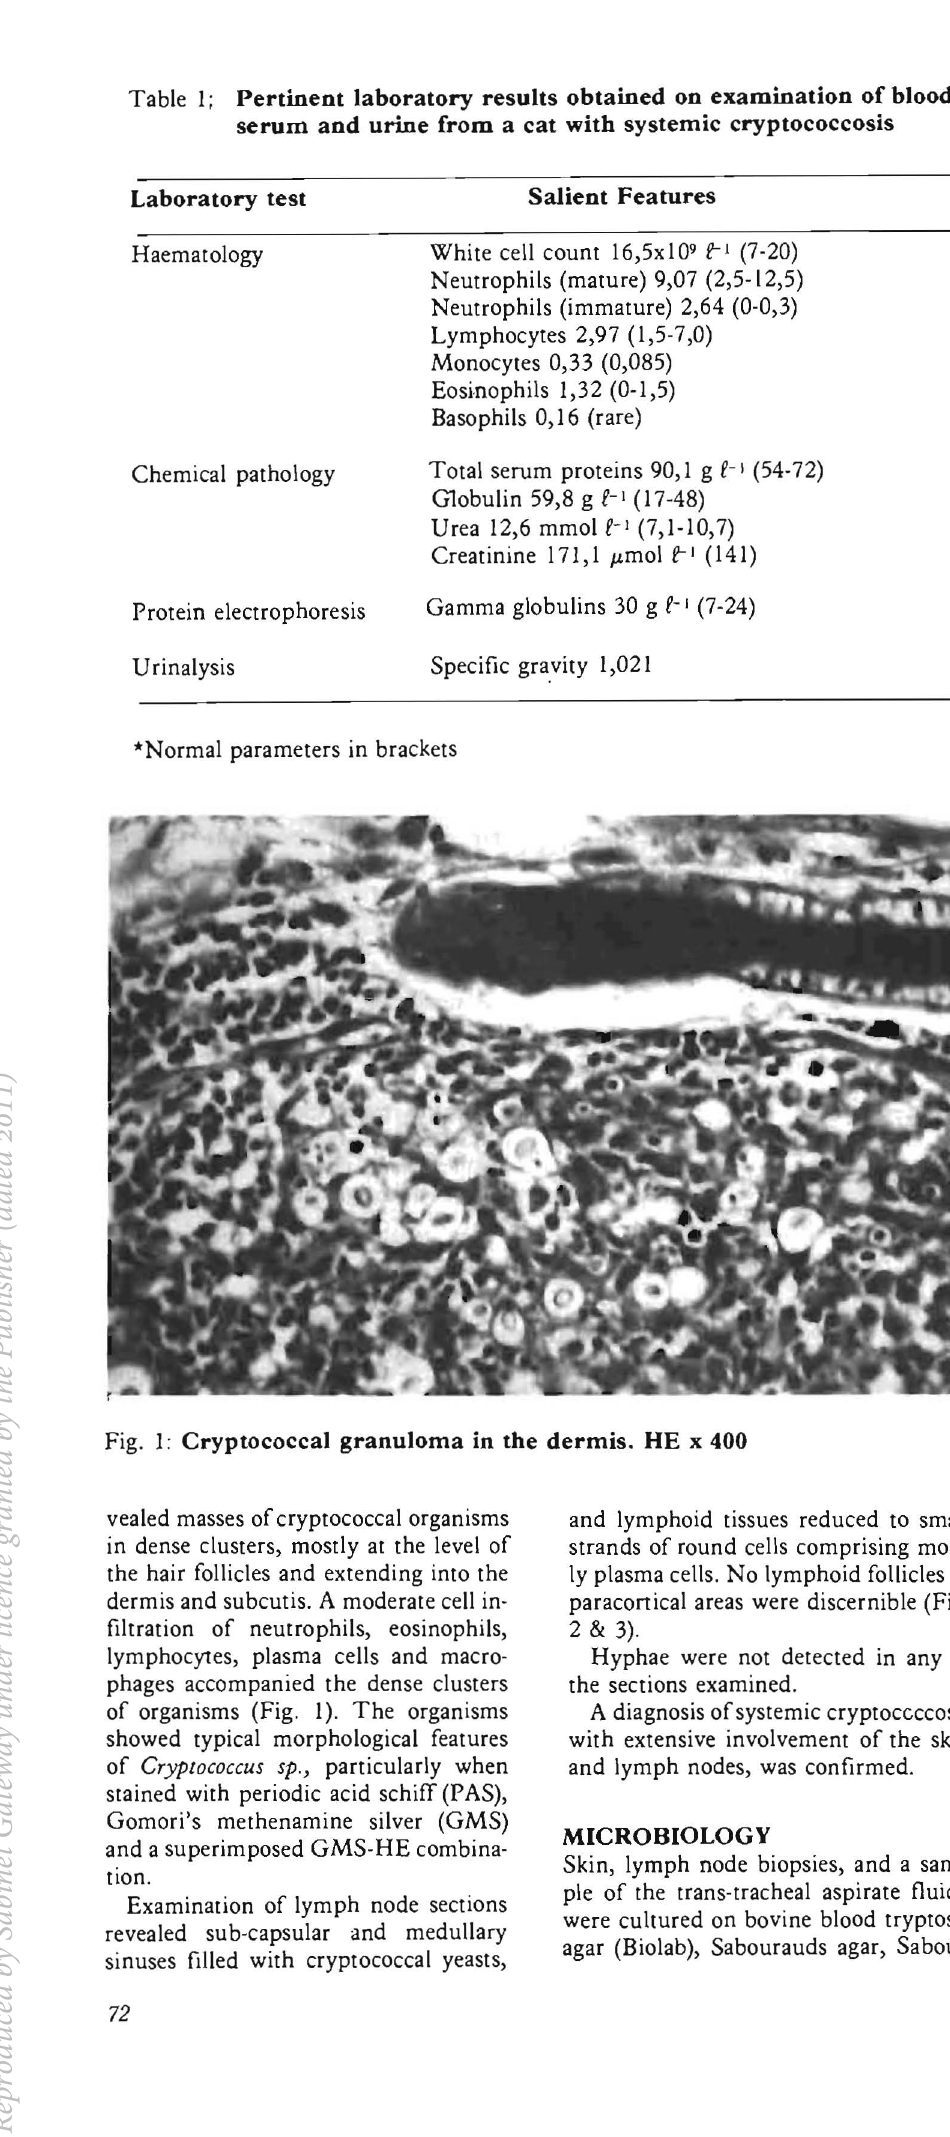
Table I; Pertinent laboratory results obtained on examination of blood, serum and urine from a cat with systemic cryptococcosis Laboratory test